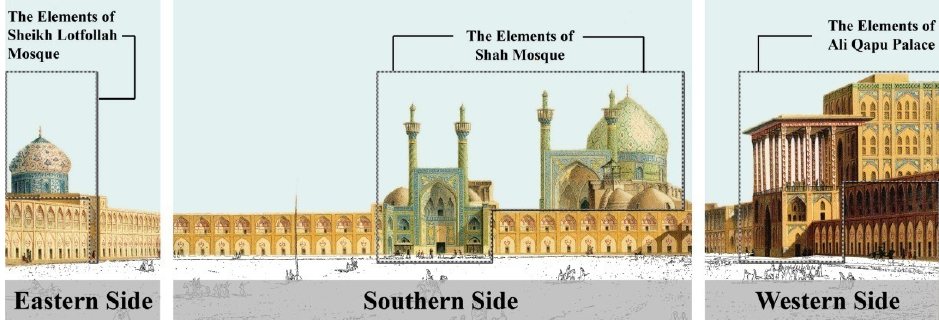
Figure 1. Each of the main units is present on each side of the civic center (adapted from Pascal Coste, Wikimedia)